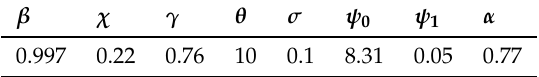
Table 1. Calbration of non-policy parameters.